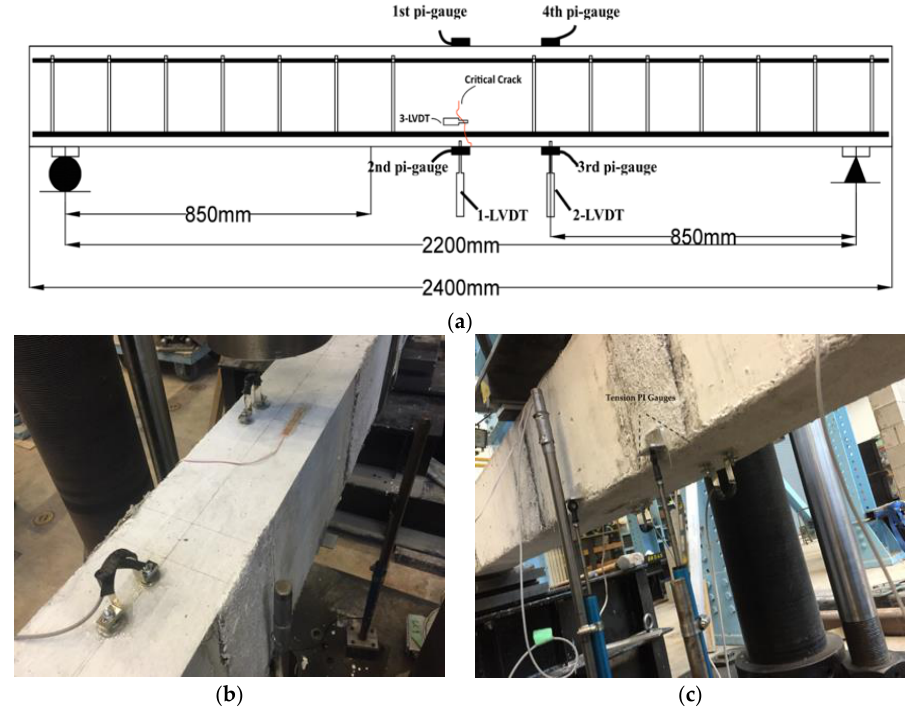
Figure 9. Instrumentation details: ( a ) sketch showing full instrumentation set-up; ( b ) photo showing top compression PI gauges and concrete strain gauges; ( c ) photo showing the linear variable differential transducers (LVDTs) and bottom tension PI gauges.